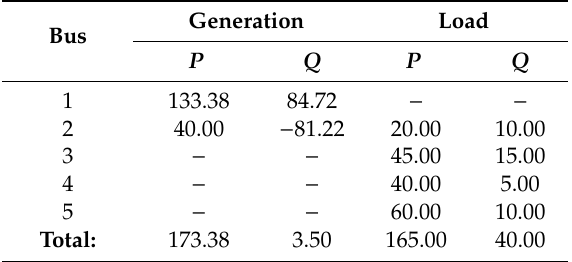
Table A22. Results of the mixed AC / DC PF calculations in Case 6-1. AC bus data.